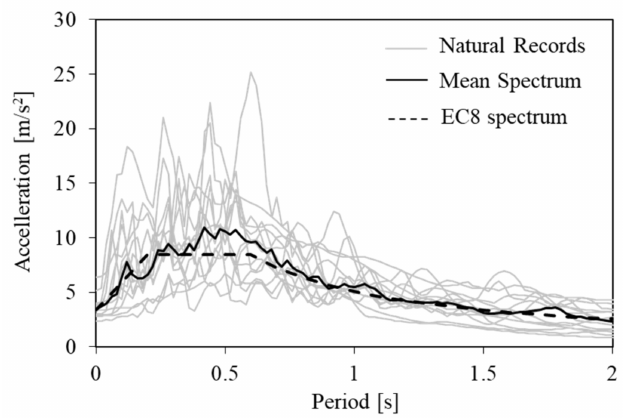
Figure 3. Selected earthquake acceleration